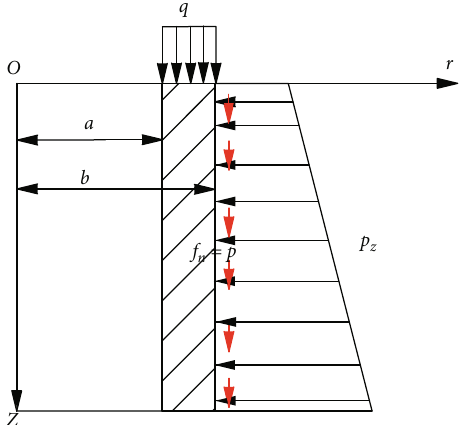
Figure 8: Simpli fi ed mechanical model of the shaft